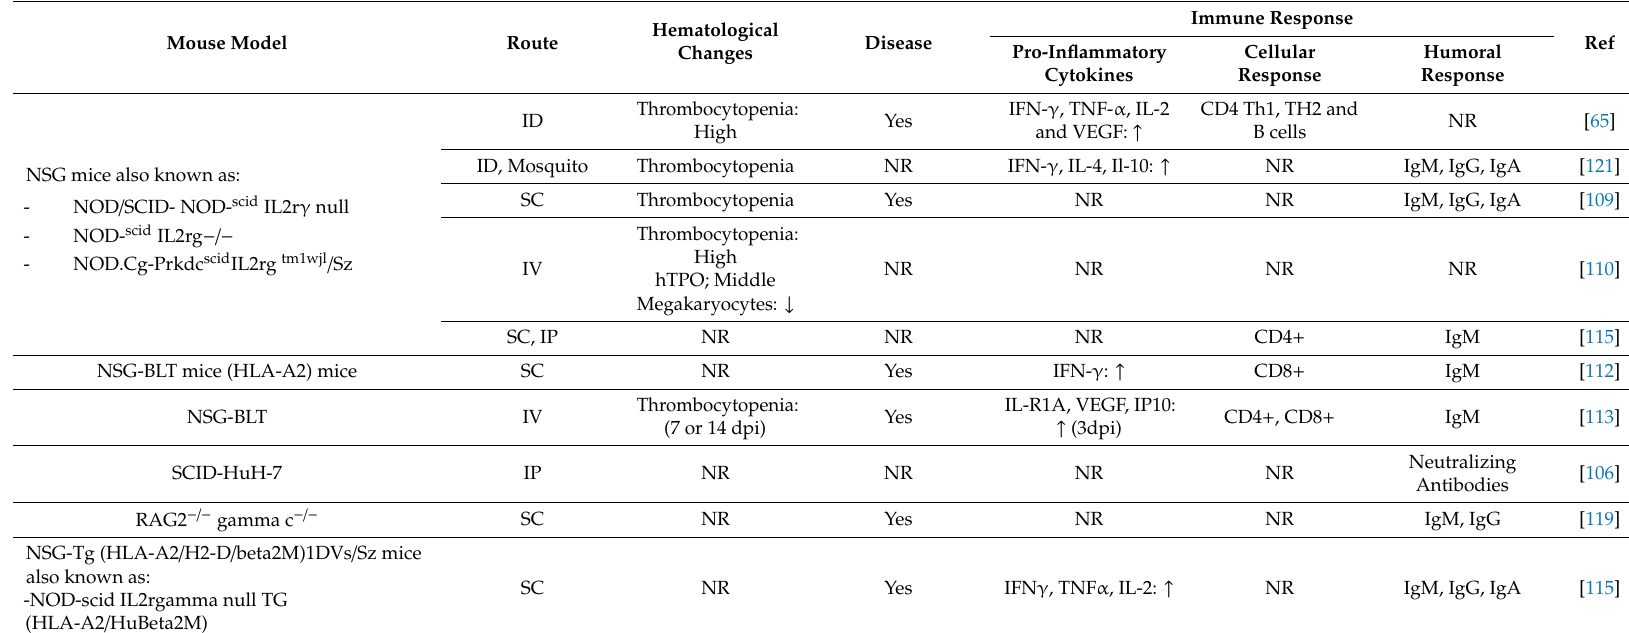
Table 2. Humanized mouse models for dengue